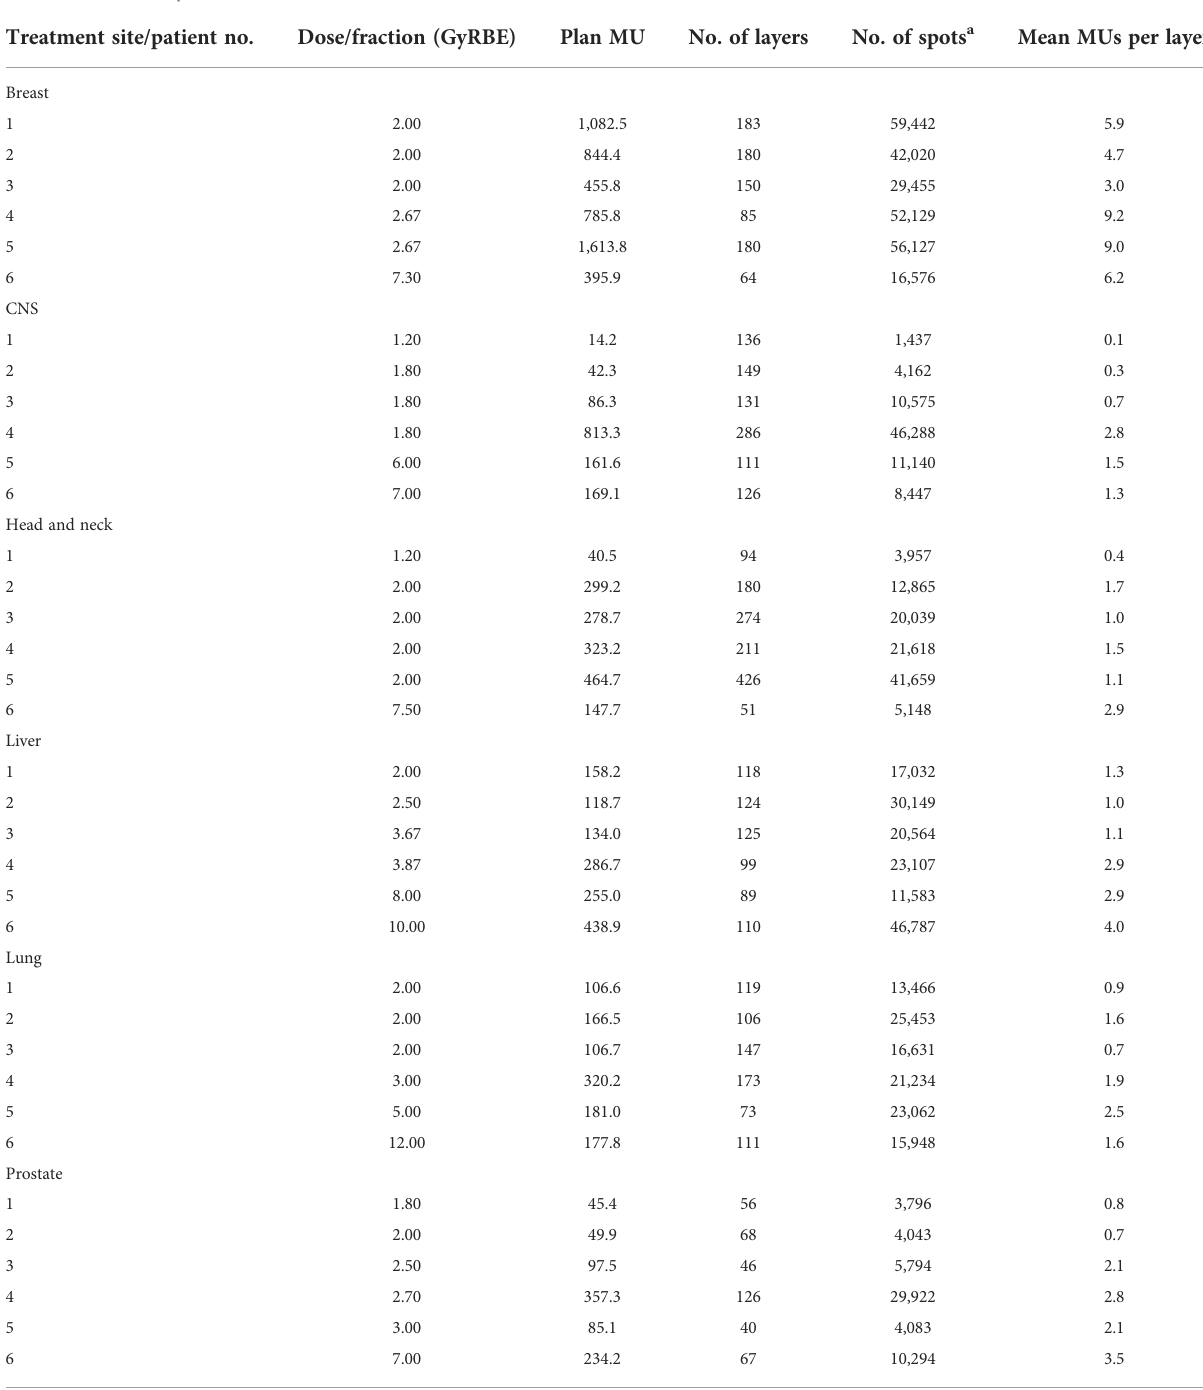
TABLE 1 Treatment plan characteristics. Treatment site/patient